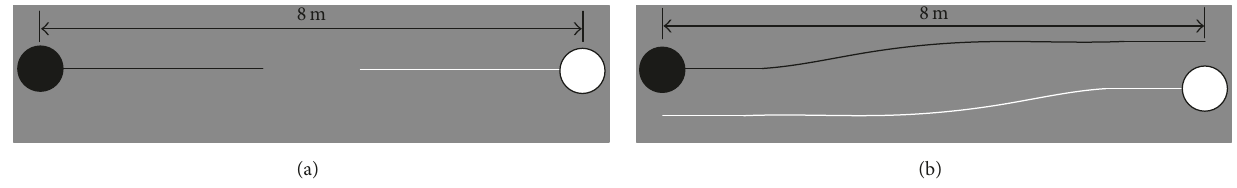
Figure 10: The moving trajectory in the “face-to-face” case and the “brush past” case. (a) is the “face-to-face” case, where 𝑙 𝑖𝑗 = 0 m (Path Figure 2), and (b) is the “brush past” case, where 𝑙 𝑖𝑗 = −0.3 m (Path